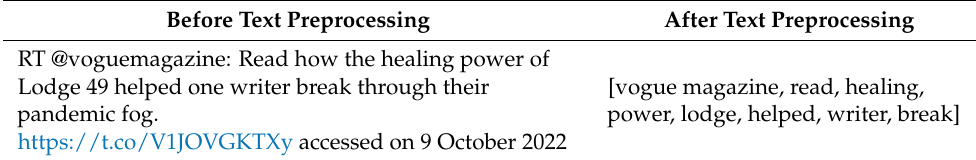
Table 2. Text preprocessing before and after contrast